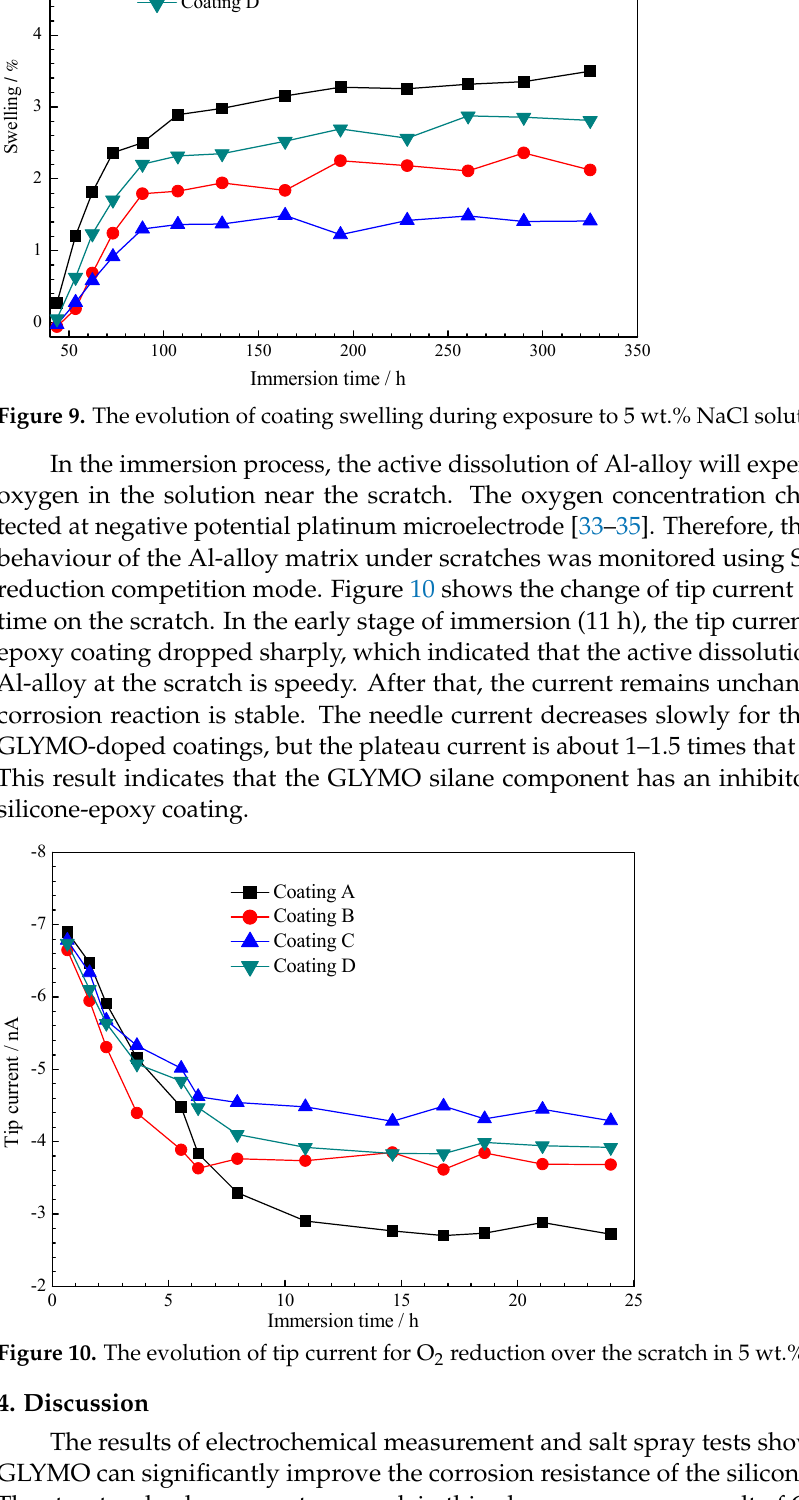
Figure 10. The evolution of tip current for O 2 reduction over the scratch in 5 wt.% NaCl solution.